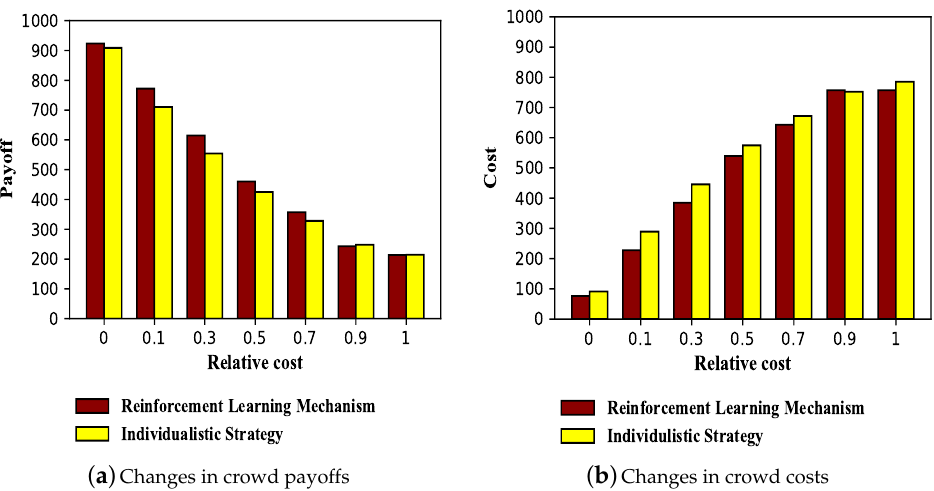
Figure 6. Relationship between the overall payoffs and costs of the population and the relative cost. ( a ) The change of population payoffs with a relative cost. ( b ) The change of population cost with the relative cost. With the increase of the relative cost, the payoffs of the crowd are decreasing, whereas the costs of the crowd are rising. Basically, the total payoffs of the population under the reinforcement learning mechanism are always higher than that of the individualism mechanism, and the total cost of the population is always lower than that of the individualism